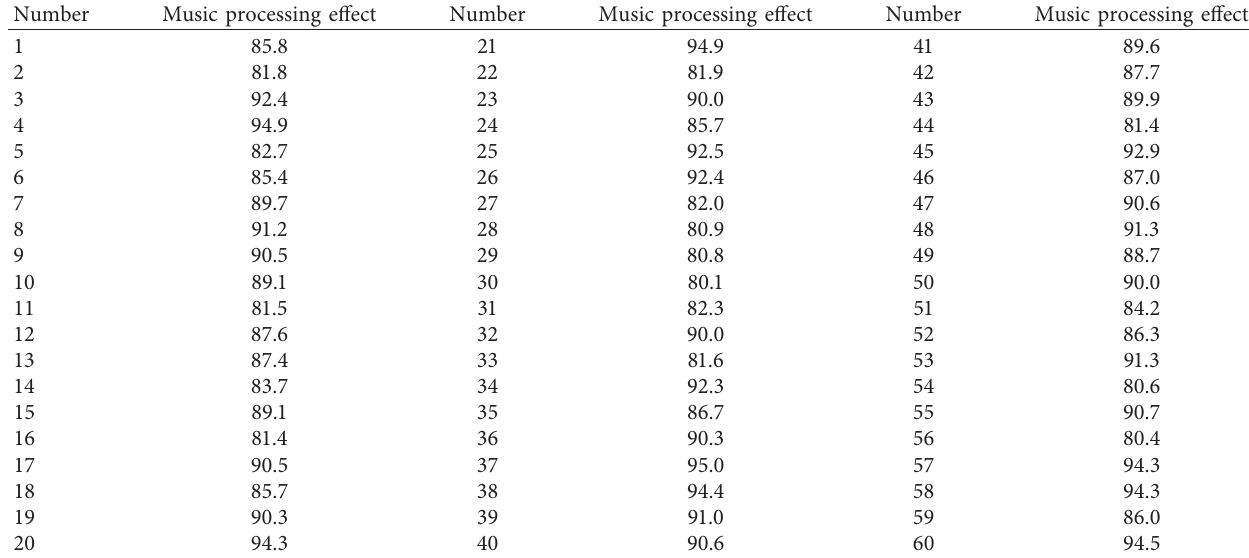
Table 1: Evaluation of the music processing effect of the multimedia-assisted music teaching system based on AI and multimedia technology.